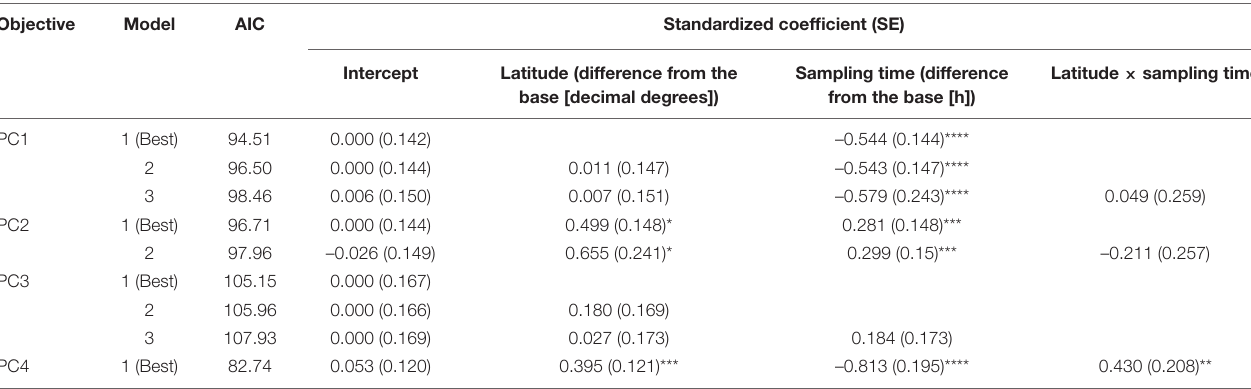
TABLE 2 | Top three models explaining the respective principal component (PC)